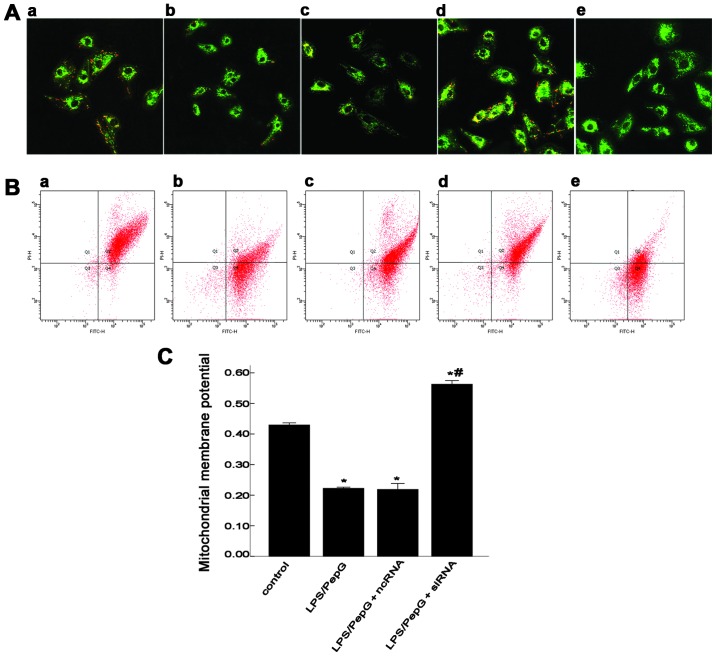
Effect of siRNA on mitochondrial membrane potential (MMP or ΔΨm) in H9C2 cells under septic conditions. (A) Scanning of MMP in H9C2 cells using a confocal microscope. Green fluorescence represents the monomeric form of the JC-1 molecule, which appears in the cytosol after mitochondrial membrane depolarization. Red fluorescence reveals the mitochondrial aggregate form of JC-1, indicating MMP (magnification, x40). (B) Evaluation of MMP in H9C2 cells by flow cytometry (FCM). FITC-H, green; PI-H, red. (A and B) Panel a, control group; panel b, lipopolysaccharide (LPS)/peptidoglycan G (PepG) group; panel c, LPS/PepG + negative control siRNA (ncRNA) group; panel d, LPS/PepG + siRNA group; panel e, carbonyl cyanide m-chlorophenylhydrazone (CCCP)-treated cells. (C) The ratio of the red over the green fluorescence intensity by FCM represents the quantitative MMP in each group. Values are expressed as the means ± SD. *P<0.05 vs. control. #P<0.05 vs. LPS/PepG group. n=3 per group.